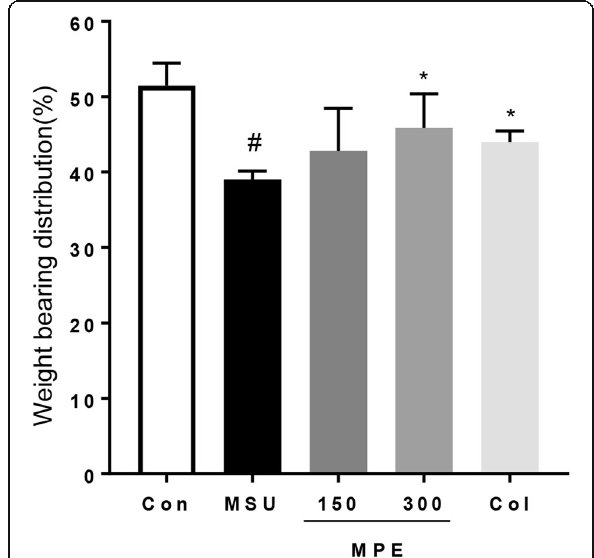
Fig. 2 Effect of MPE on changes in hind paw weight-bearing distribution in MSU-induced gouty arthritis. The weight-bearing distribution ratio was measured using a dynamic weight bearing (DWB) device, compared to that of the MSU crystal-induced group. Con, control mice; MSU, MSU crystal-induced mice; MPE, MSU mice treated with 150/300 mg/kg of MPE; Col, MSU mice treated with 1 mg/kg of colchicine. Data are presented as the mean ± SEM ( n = 5). # p < 0.001, vs. control group; * p < 0.05, vs. MSU